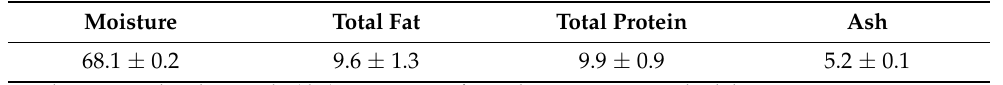
Table 2. Proximate analysis of the semi-solid paste (SSP) obtained from fresh olive pomace. Moisture Total Fat Total Protein